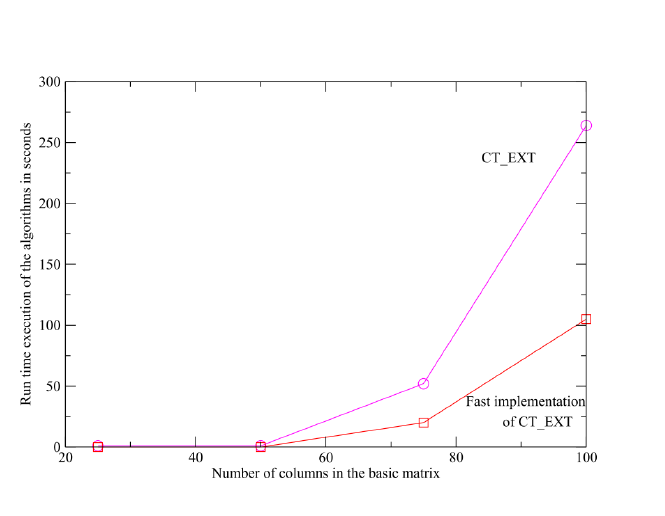
Fig. 1. Runtime in seconds of CT EXT algorithm and the fast implementation, as the number of rows increases